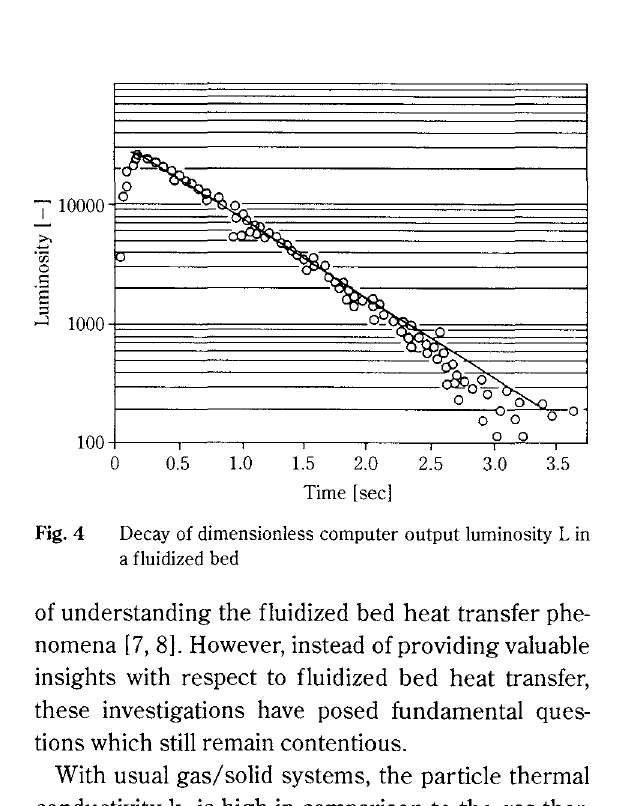
Decay of dimensionless computer output luminosity L in